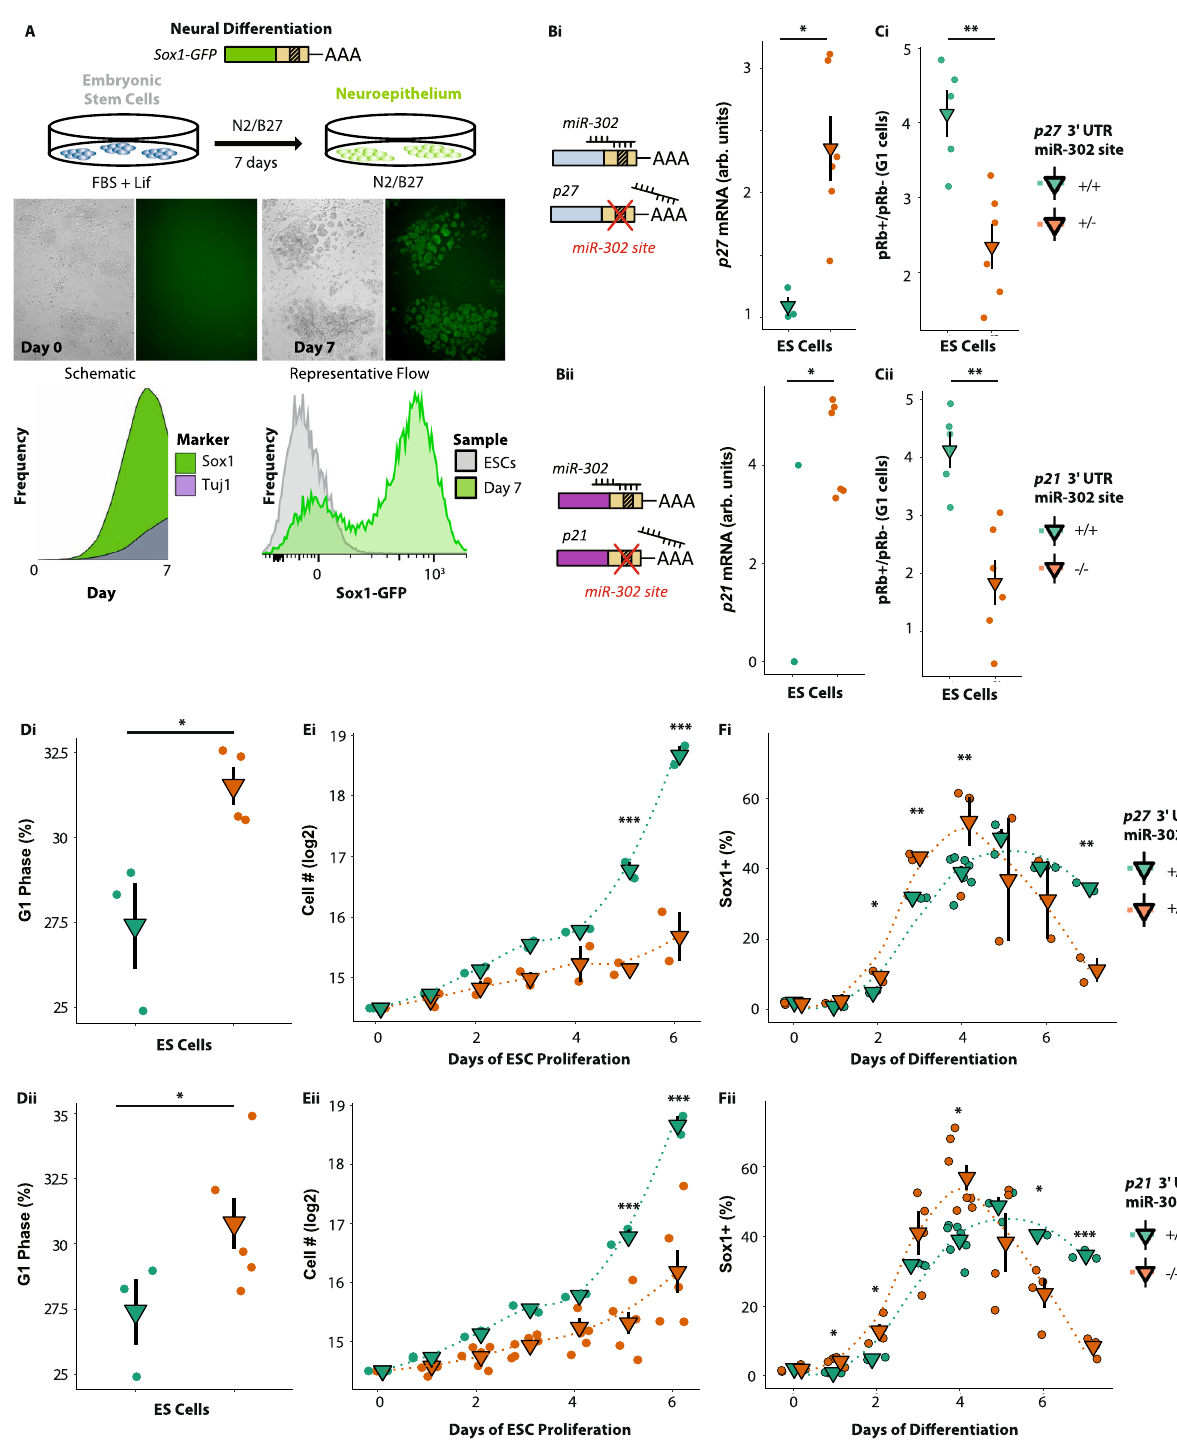
site (Supplementary Fig. 9A). We analyzed the phasic activity of these mutants by evaluating Rb phosphorylation (pRb) across the cell cycle during neural directed differentiation. Both wild-type and mutant cell lines showed constitutive Rb phosphorylation in ESCs. However, while wt and the truncated mutant cell lines showed a gain in phasic Rb phosphorylation during ESC differentiation (Supplementary Fig. 9B), the segment duplicated mutant line retained constitutive Rb phosphorylation even after 7 days in neural differentiation conditions (Fig. 7B). Furthermore, while Cyclin E1 protein levels in G1 became varied in wt